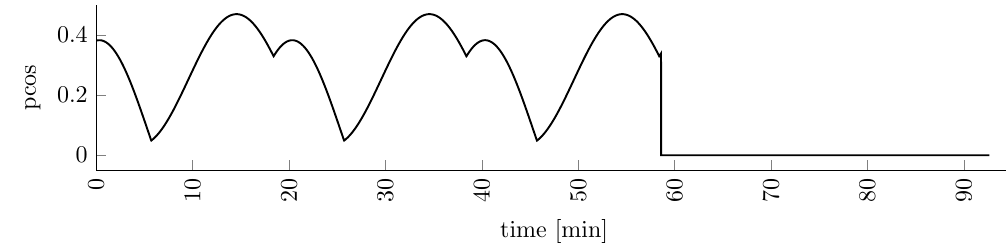
Figure 6. Pseudo-cosine simulation results for one orbital period.